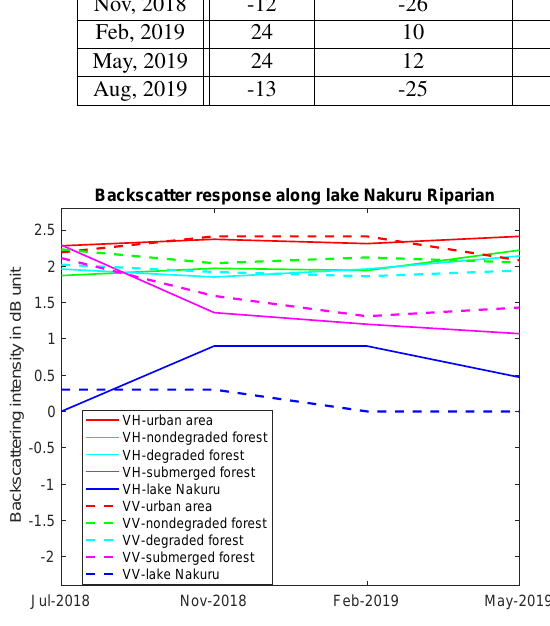
Figure 6: Time series of the backscatter response (db) on riparian land cover